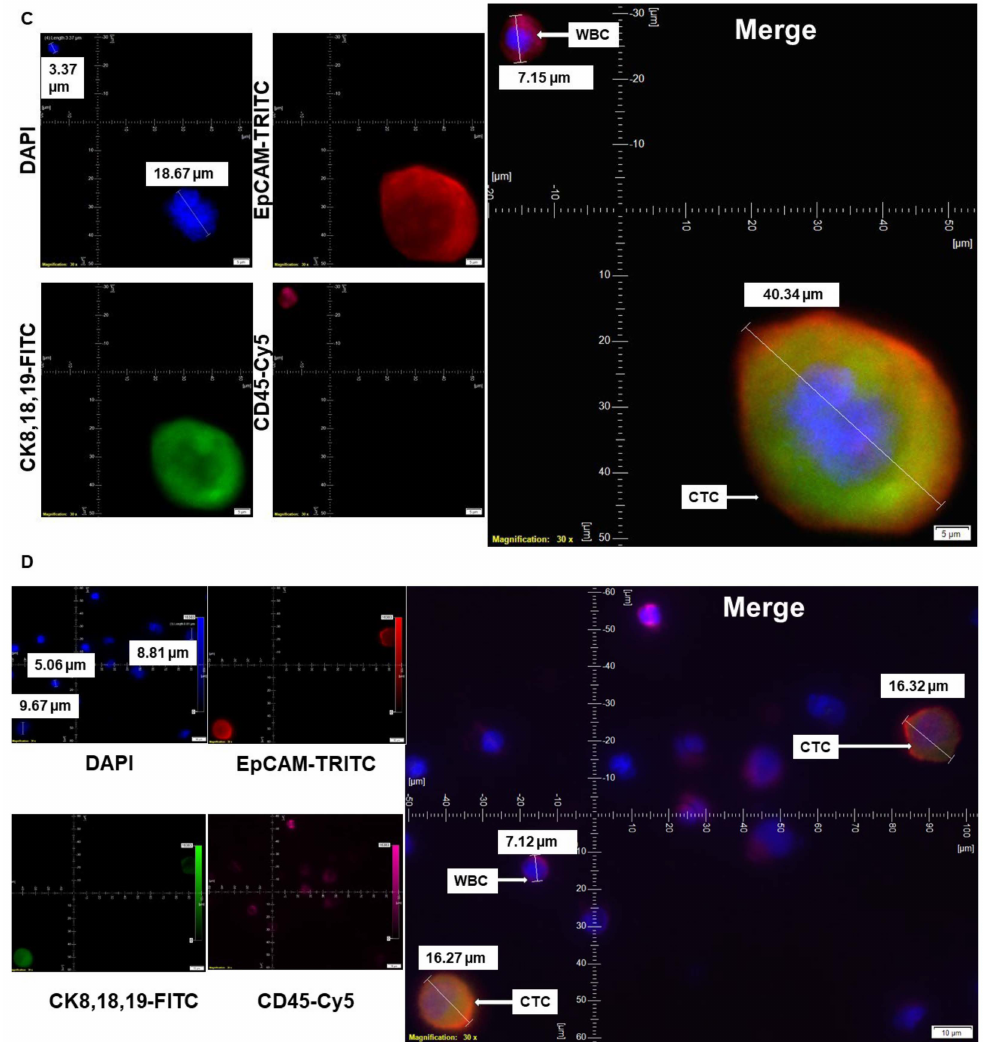
Figure 1. Standardization and validation of CTC by IF × 3 using breast, ovarian, and lung cancer cell lines: Patients’ blood samples spiked with titrating number (1000 cells, 750 cells, 375 cells, 250 cells/100 cells) of cell lines of different solid tumors using. Pictures were taken at 60 × oil objective of an Olympus IX71 Microscope with DAPI/FITC/TRITC/CY5 filter sets. ( A ): MCF7 cells (750 cells/375 cells per 7.5 mL of patient’s blood) were used for spiking blood samples, and cells were captured on a microfilter and stained with a CellSieve enumeration kit (Creatv Microtech) with either DAPI/CK-FITC/EpCAM-PE/CD45-Cy5 ( Ai ) or DAPI/CK-FITC/CD31 PE/CD45-Cy5 ( Aii ). ( B ): OVCAR3 cells (100 cells per 7.5 mL of patient’s blood) were used for spiking blood samples, and cells were captured on a microfilter and stained with cell sieve enumeration kit (Creatv MicroTech) with DAPI/CK-FITC/EpCAM-PE/CD45-Cy5. ( C ): HCC1975 cells (1000 cells per 7.5 mL of patient’s blood) were used for spiking blood samples, and cells were captured on a microfilter and stained with cell sieve enumeration kit (Creatv Microtech) with DAPI/CK-FITC/EpCAM-PE/CD45-Cy5. ( D ): NCI-H441 cells (250 cells per 7.5 mL of patient’s blood) were used for spiking blood samples, and cells were captured on a microfilter and stained with cell sieve enumeration kit (Creatv Microtech) with DAPI/CK-FITC/EpCAM-PE/CD45-Cy5. The magnification, scale bar, and digital reticle are represented for each photomicrograph. Fluorescence images from DAPI, FITC, TRITC, and Cy5 channels were separated as pictures with a color bar. The fluorescence-photomicrographs presented the diameters ( µ m) of CTC and a representative WBC and their respective DAPI stained